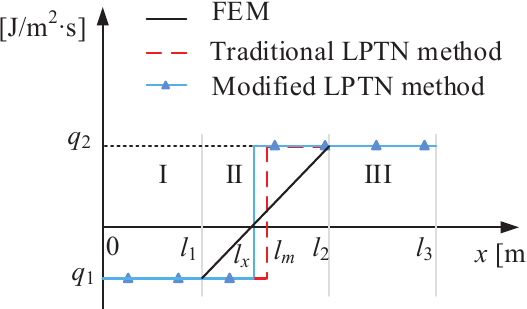
Figure 3. Heat flux for FEM, half power and traditional